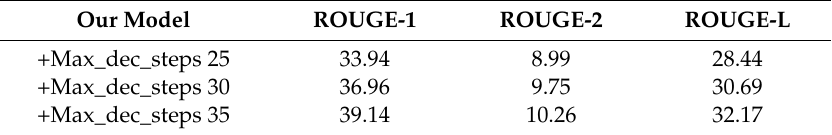
Table 8. Results for DUC-2004. +Max_dec_steps (25/30/35) represents setting different lengths for Max_dec_steps. Our Model